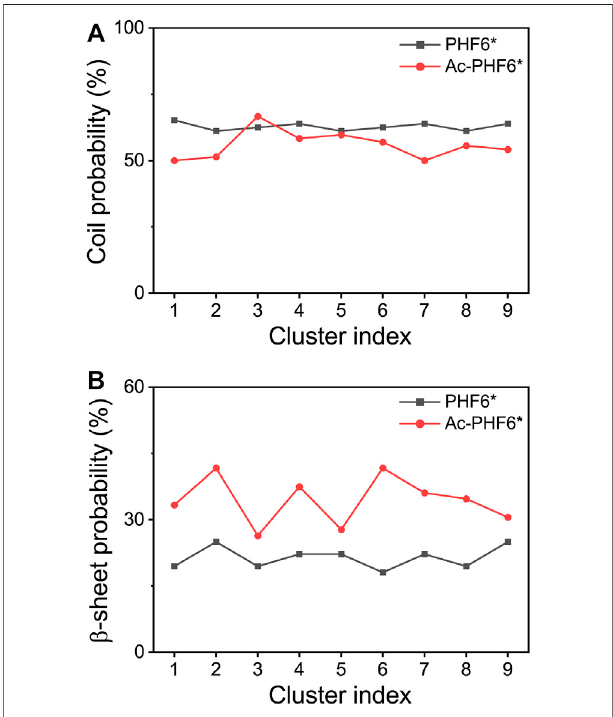
FIGURE 3 | Averaged probabilities of coil (A) and β -sheet (B) as a function of cluster index in two systems. The cluster with lower index has a higher sampling